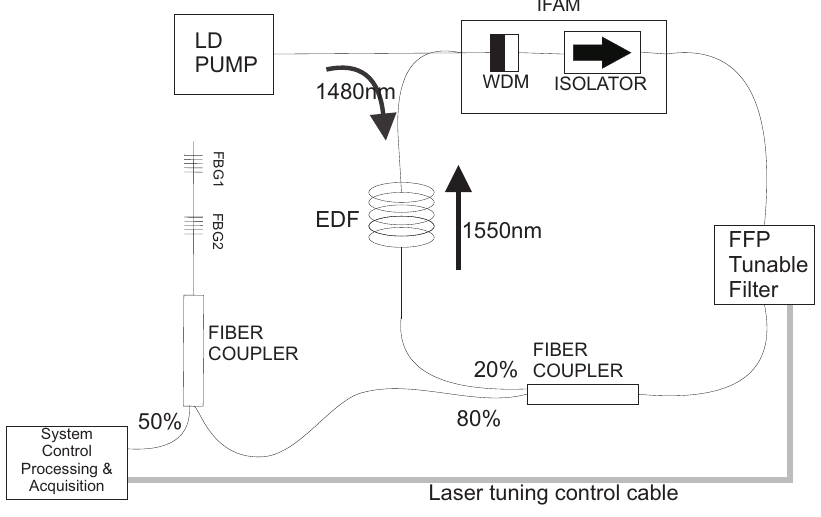
Figure 1. System schematic diagram for the interrogation of FBG sensors, FBG1 and FBG2, with an Erbium-doped fiber laser (EDFL), a tunable Fabry-Perot filter, EDF in a ring cavity and electronic tuning